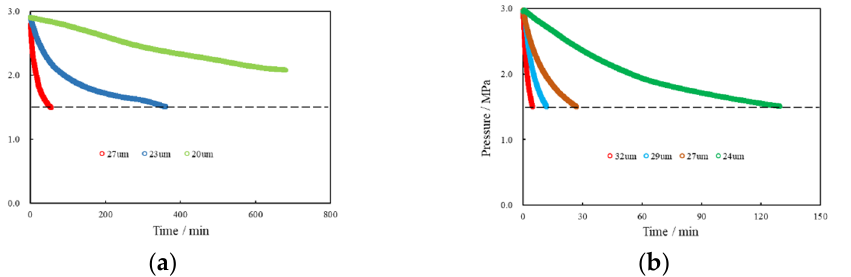
Figure 8. The influence of confining pressure on fracture connectivity. ( a ) Sample L-1; ( b ) sample Y-3.